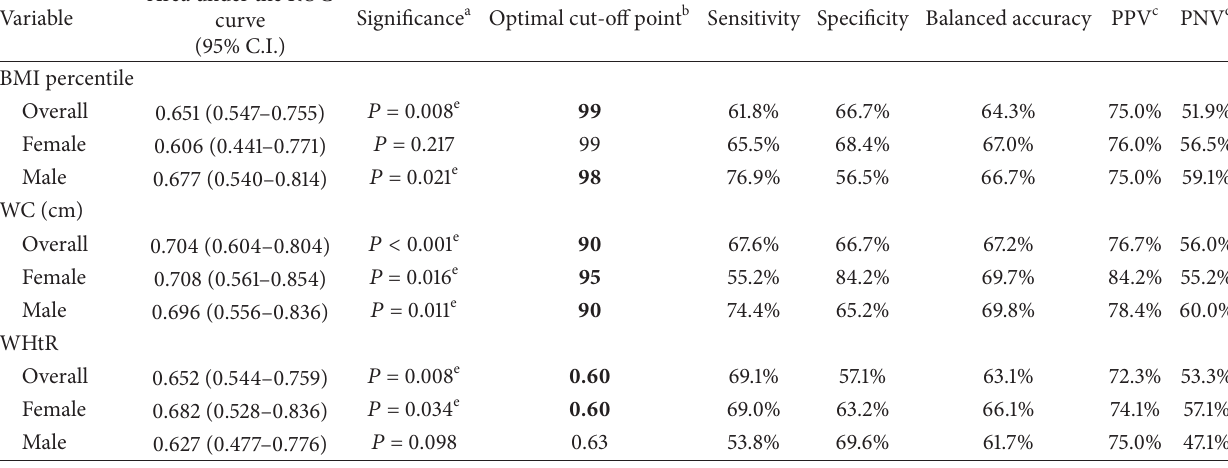
Table 4: Area under the ROC curves and 95% confidence intervals for the selected anthropometric indices, with cut-offs for the sensitivity, specificity, balanced accuracy, PPV, and PNV of an MS diagnosis. Area under the Variable